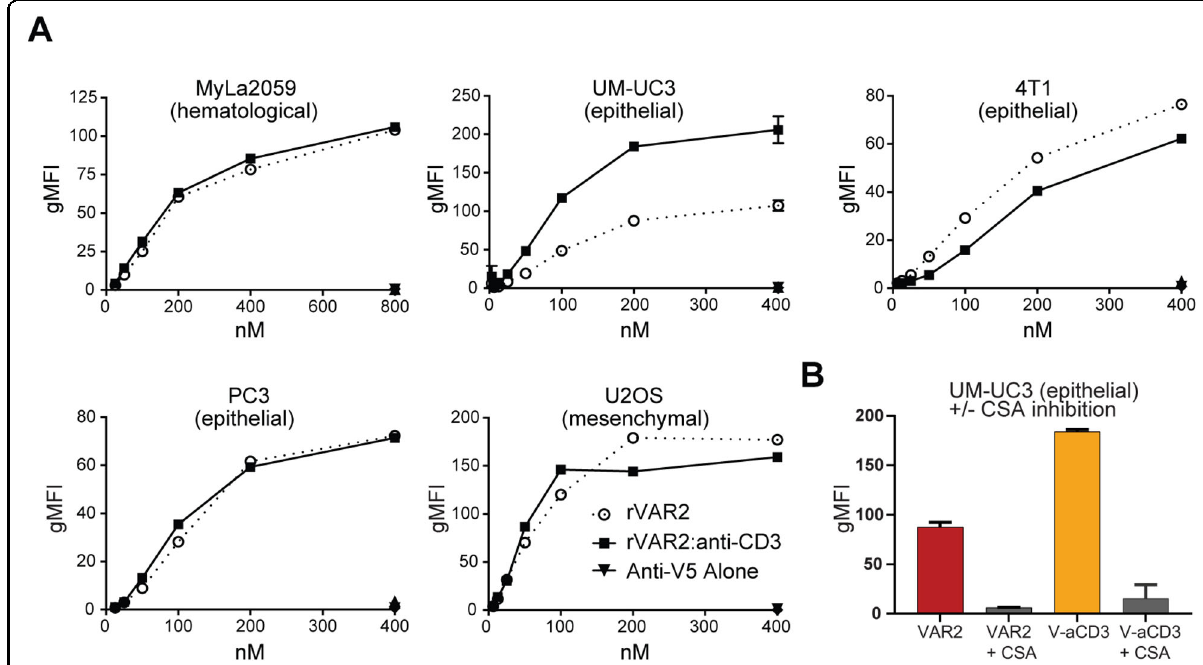
Fig. 2 rVAR2 and V-aCD3 bind cancer cells and malignant tissue. A Binding was assessed by fl ow cytometry. Graphs represent binding based on Geometric mean fl uorescence intensity (gMFI) Flow cytometer measurements of binding to various cancer cell lines of different origins. Stippled lines show binding to VAR2, solid lines show binding to V-aCD3. The V-aCD3 and rVAR2 bound to all cancer cell lines and the antibody alone did not show any binding. B Binding of VAR2 and V-aCD3 to cancer cells are inhibited by competition with puri fi ed